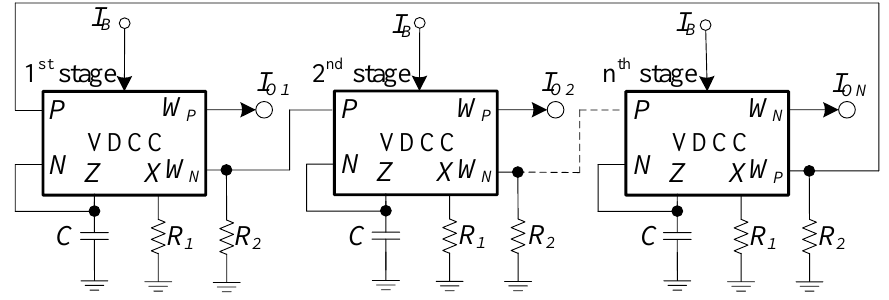
Figure 5. Proposed even-phase MSO with high impedance at current output nodes.